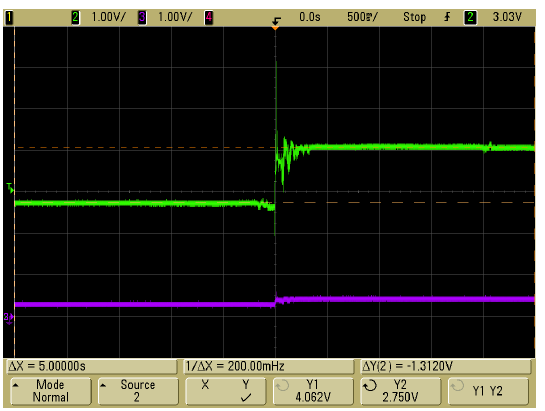
Figure 11. Response to the weights.